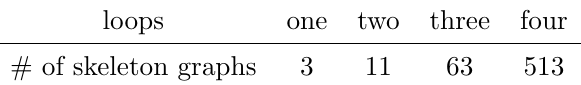
Figure 1 . The skeleton graphs used for the one-loop computation of a four-point function. The ribbon graphs are obtained from these by adding colours traces. Only the (cid:12)rst graph contributes to the particular choice of polarization, and the only con(cid:12)guration which does not vanish is when the middle vertex corresponds to the integrated Lagrangian insertion. One can easily compute it analytically with equation (B.6).